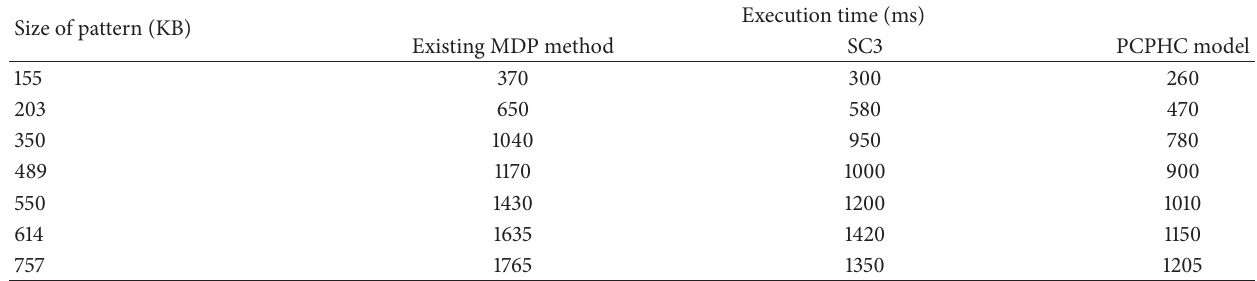
Table 1: Tabulation of execution time (using GenBank